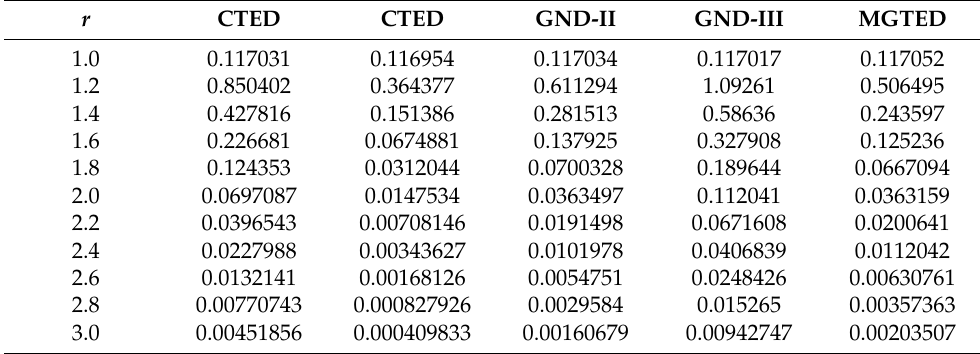
Table 6. The concentration C for different thermo-diffusion